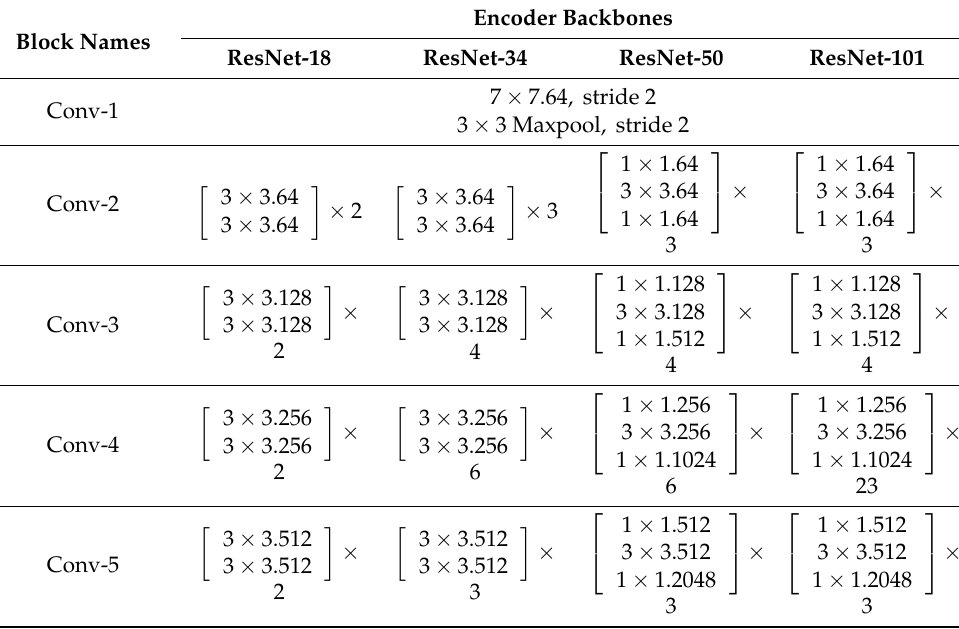
Table 5. The complete composition of the U-Net-based models with different encoders.